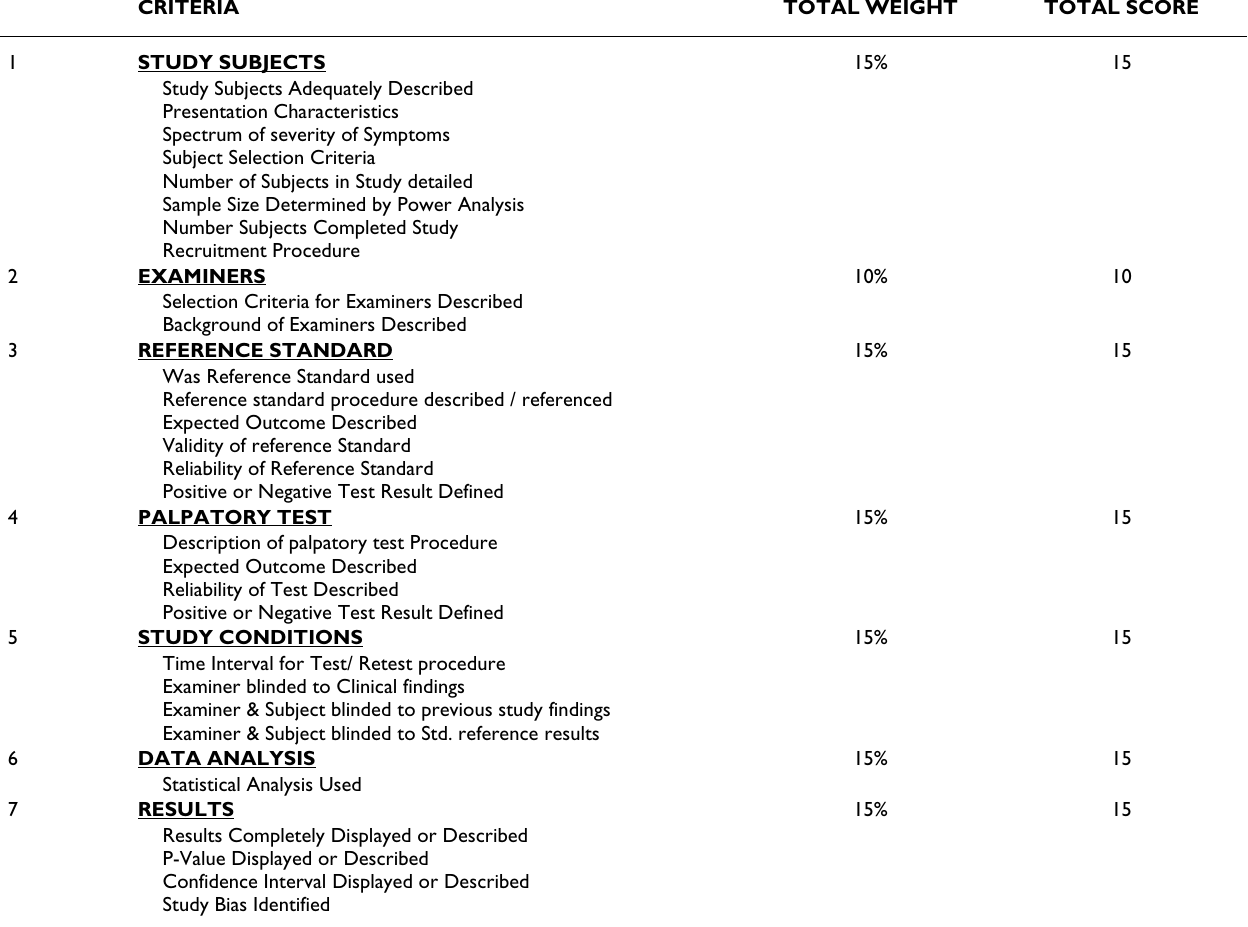
Table 2: Quality scoring criteria, total wieight and total score assigned.